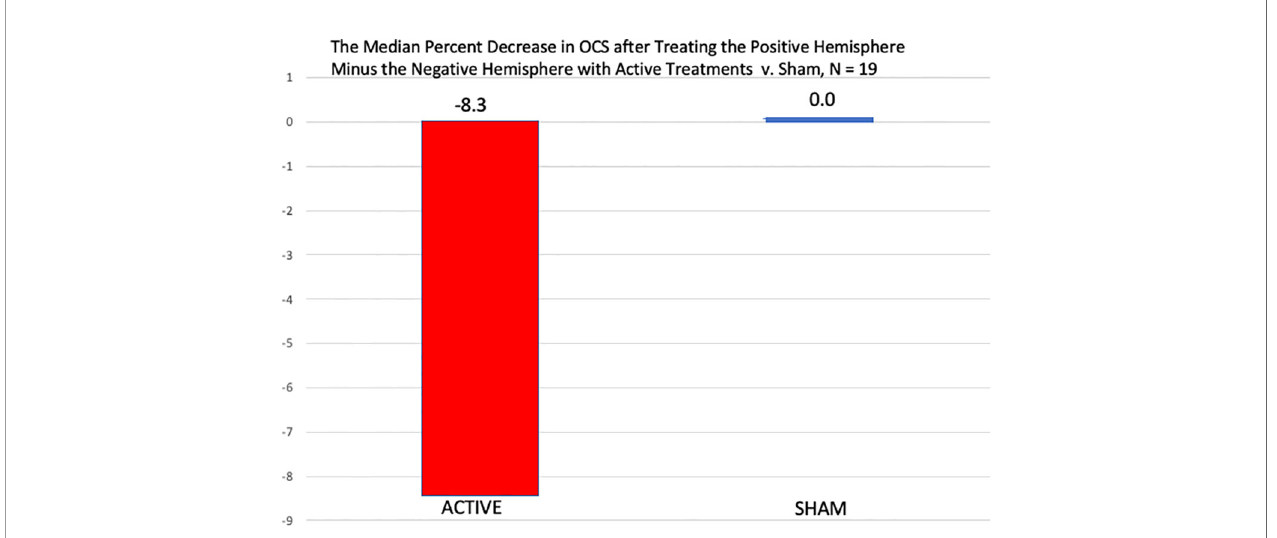
FIGURE 6 | Comparison of the median percent reduction in the OCS measures immediately after the treatment of the negative hemisphere followed by the treatment of the positive hemisphere in both the active conditions and the sham conditions. In the active conditions there was a signi fi cantly greater percent decrease in OCS when the positive hemisphere was treated than the negative, by a one-sided, Wilcoxon Test, p = 0.021, but after the sham treatments, there was no difference between the two hemispheric sham